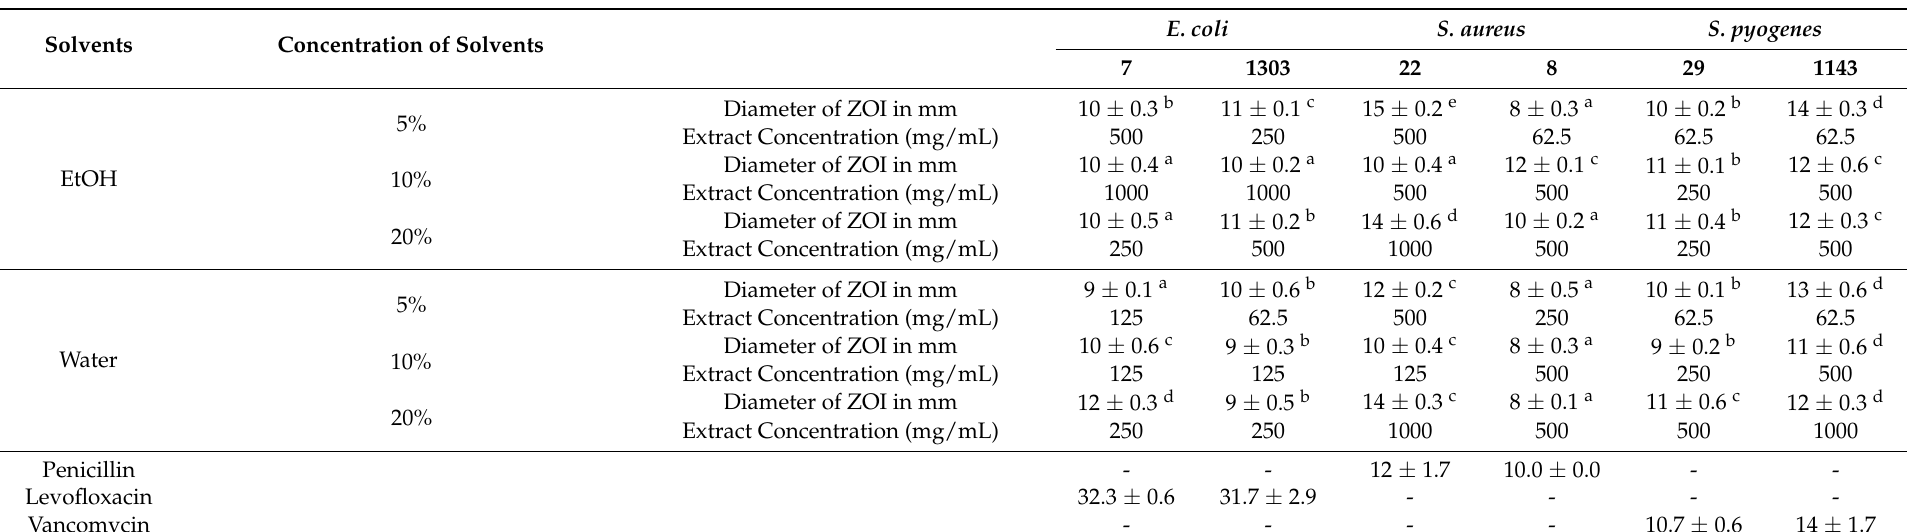
Table 3. Zones of inhibition (ZOIs) of pomegranate extract against Escherichia coli , Staphylococcus aureus , and Streptococcus pyogenes